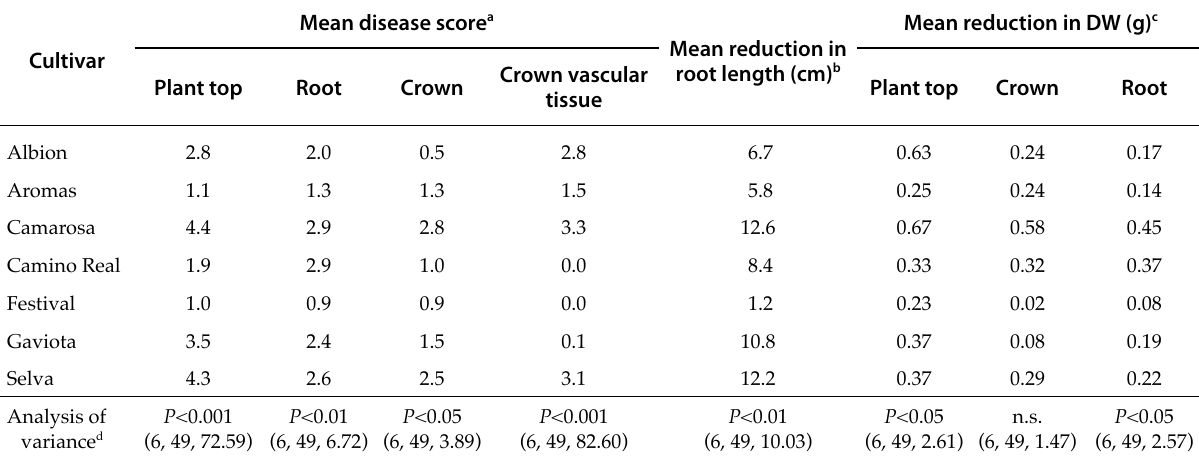
Table 4. Response of strawberry cultivars to Fusarium oxysporum (WUF-ST-FO35) assessed as disease scores for plant top (0‒5 scale where 0 = the plant well developed, no disease symptoms and 5 = plant dead), root (0‒5 scale where 0 = root well developed, no discolouration and 5 = all root discoloured (rotted), plant dead), crown (0‒5 scale where 0 = no crown tissue discoloured and 5 = all crown tissue discoloured (rotted), plant dead) and crown vascular tissue (0‒5 scale where 0 = no crown vascular tissue discoloured and 5 = all crown vascular tissue discoloured, plant dead), reduction in root length (cm), reduction in dry weight (DW) (g) of plant top, crown and root under controlled enrironment conditions and analysis of variance for each parameter assessed in relation to